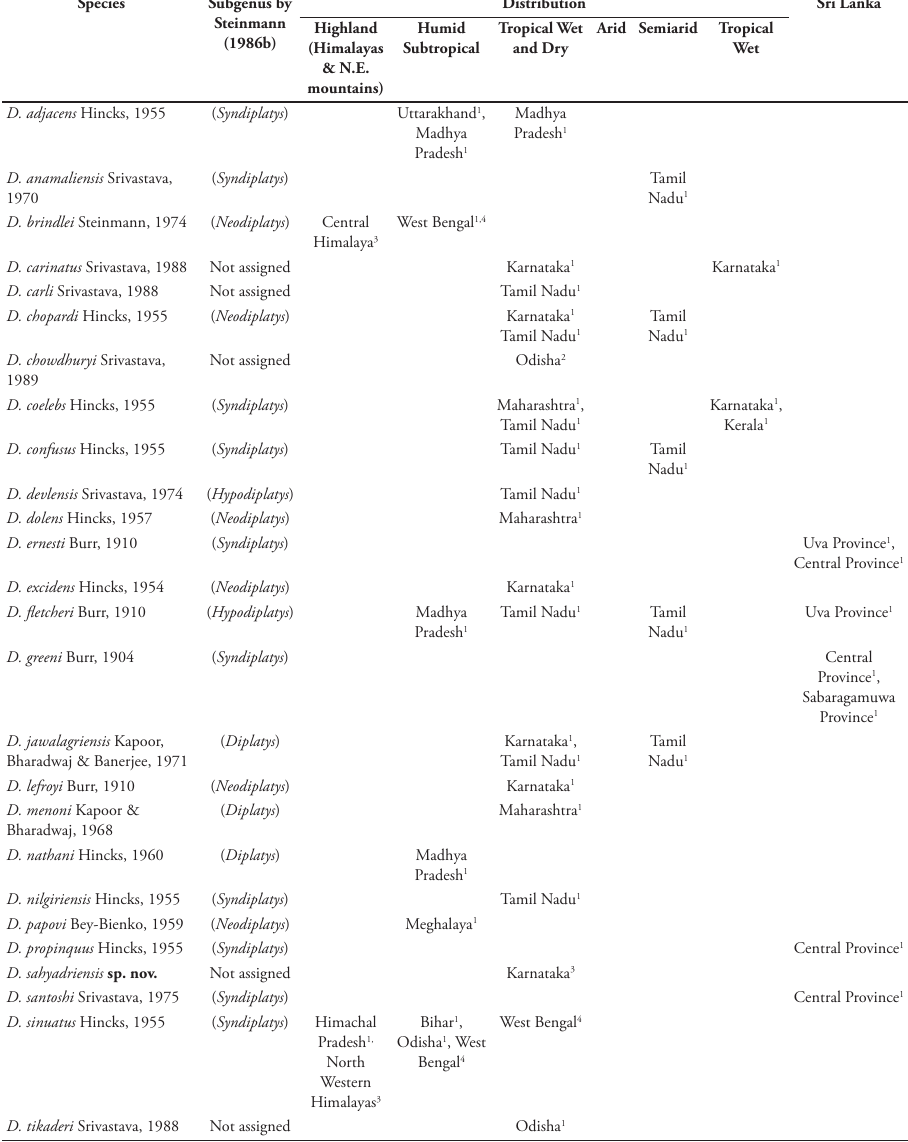
Table 1. Distribution and subgeneric classification of Diplatys species recorded from India and Sri